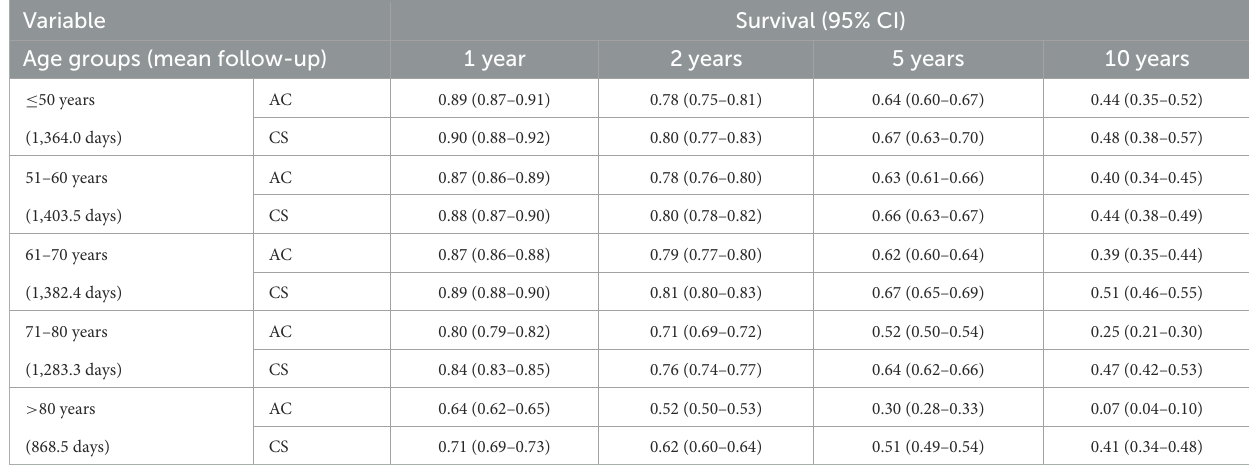
TABLE 2 Kaplan-Meier analyses for all-cause and CRC-specific survival by age groups: South Australia, 2004–2013 diagnoses, date of censoring: 31 December 2014. Variable